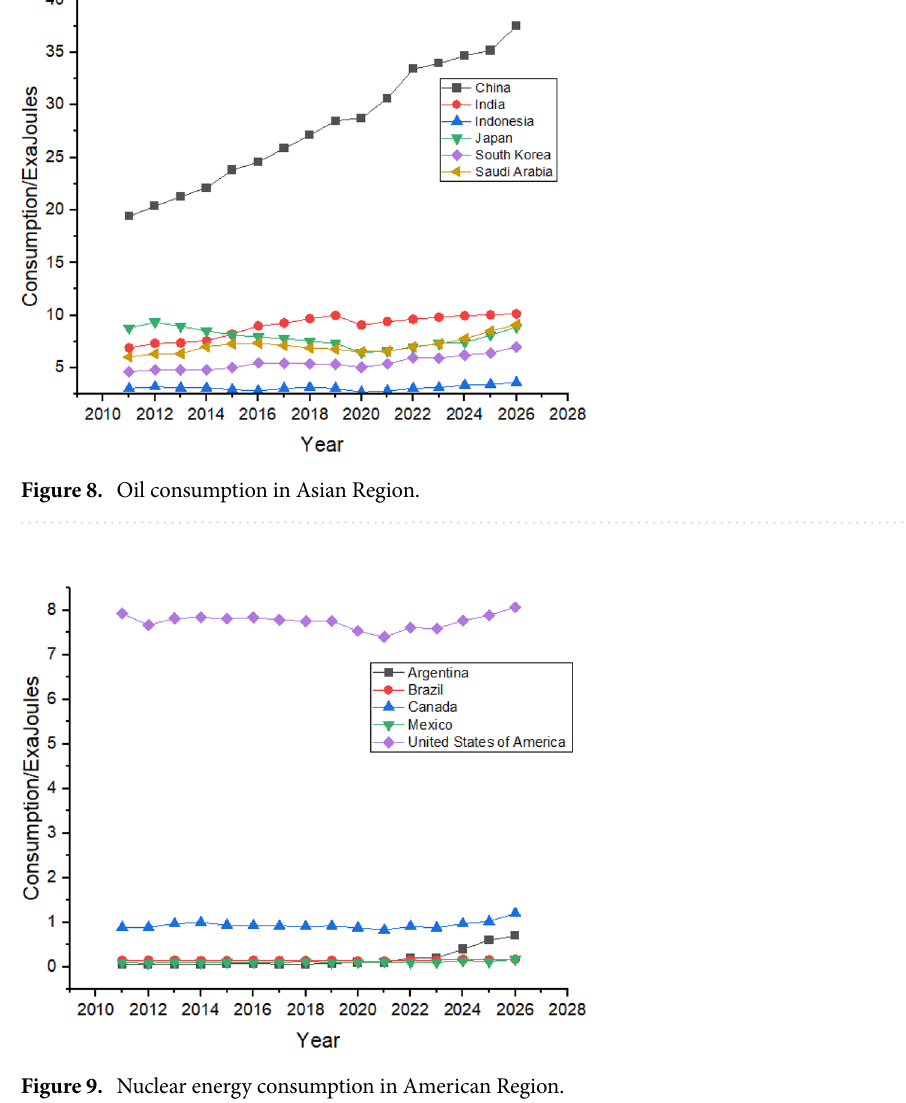
Figure 9. Nuclear energy consumption in American